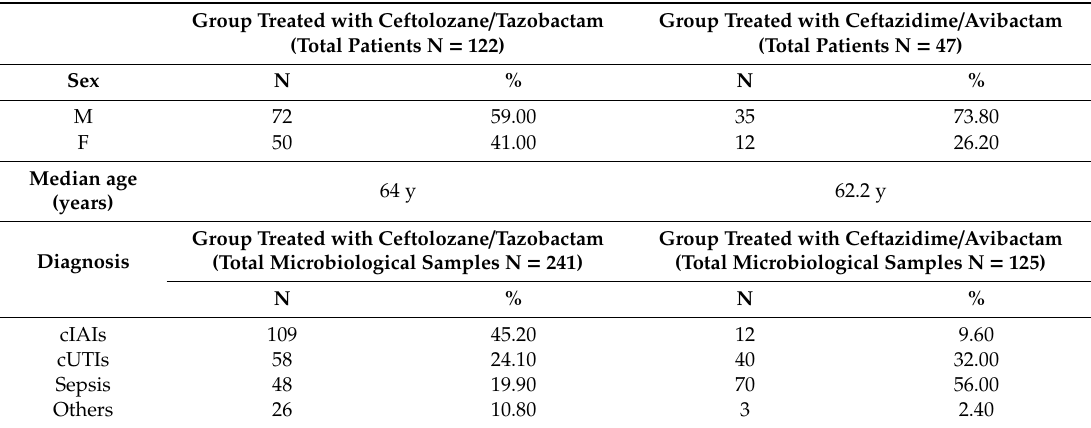
Table A1. Clinical characteristics of the patients evaluated in this study.